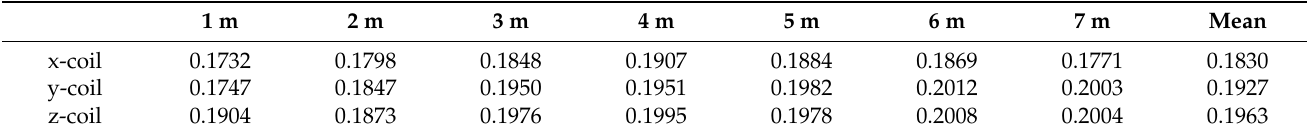
Figure 14. Underwater static positioning results (the green points are the original positioning data; the red points are the filtered positioning data; the blue points are the test points).